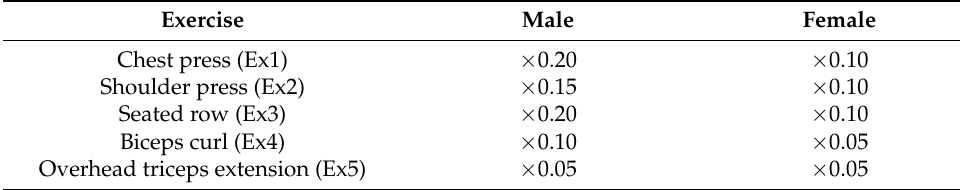
Table 1. Bodyweight ratio by sex and exercise type. [35].